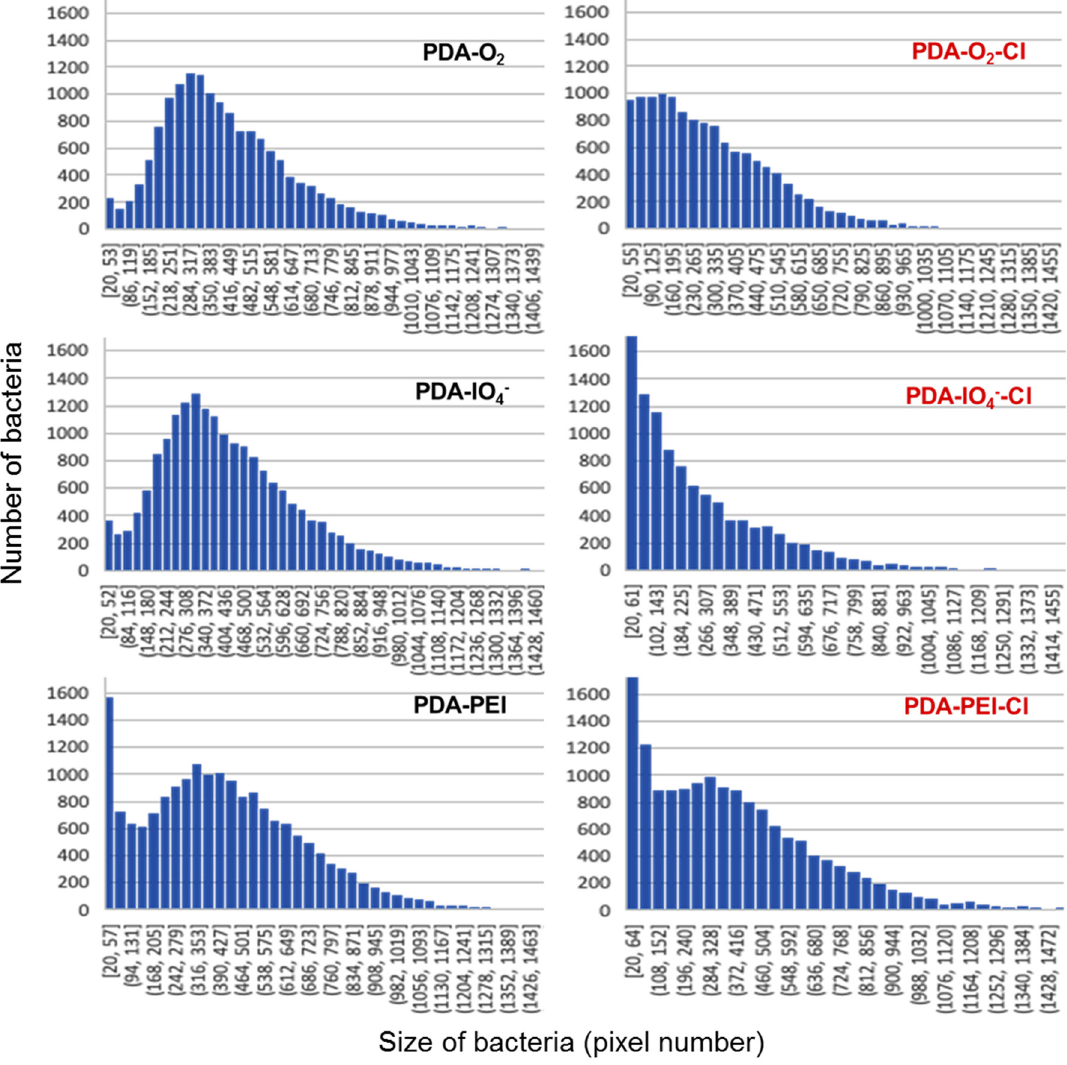
Figure 7. Size distribution (in pixels) of adhered E. coli on PDA–X and PDA–X–Cl coatings, observed by optical microscopy with green epifluorescence staining (SYTO TM 9).